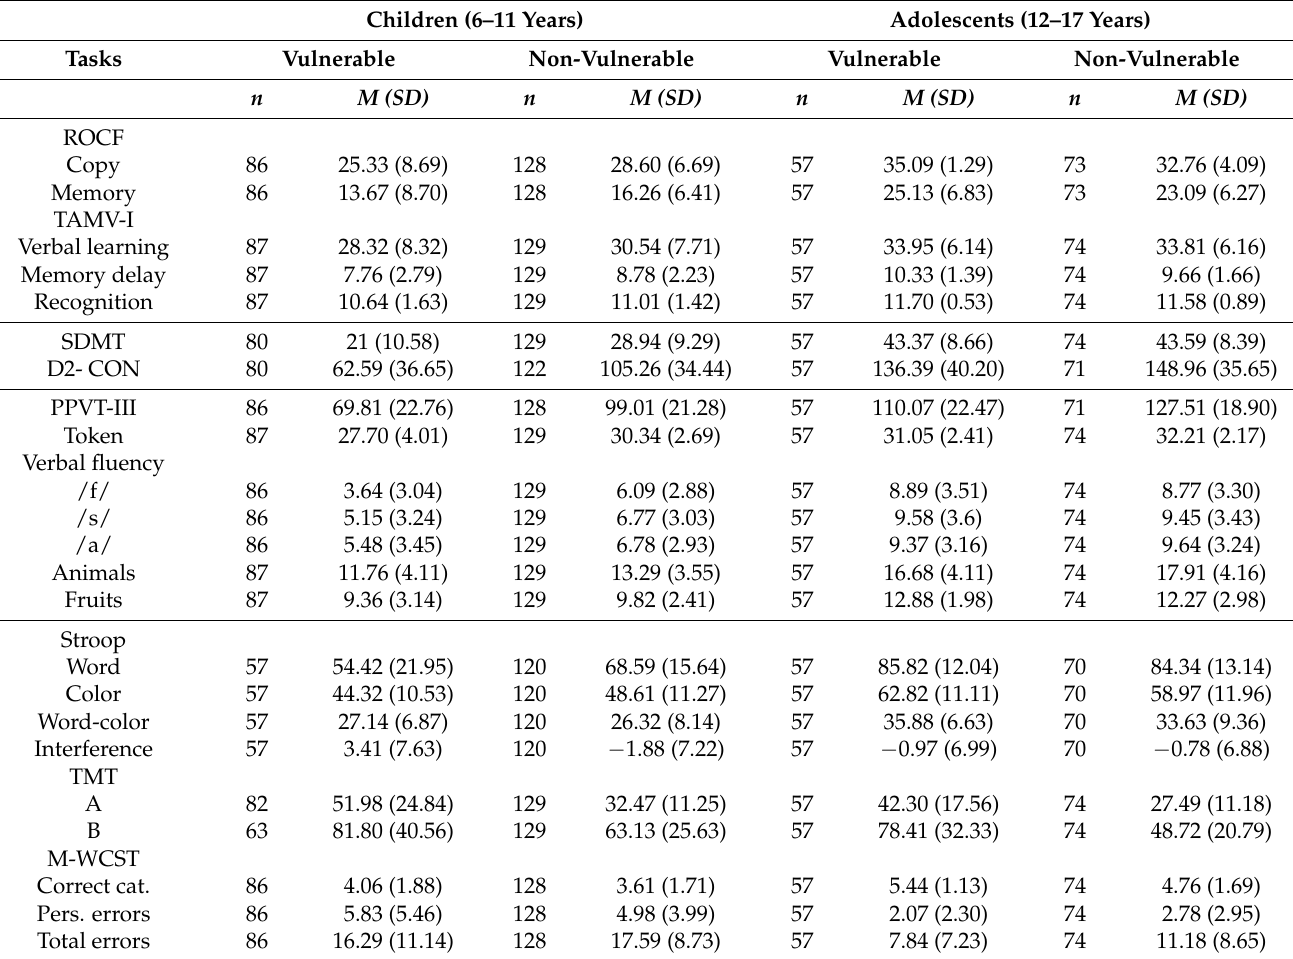
Table 5. Raw scores by age group and vulnerability